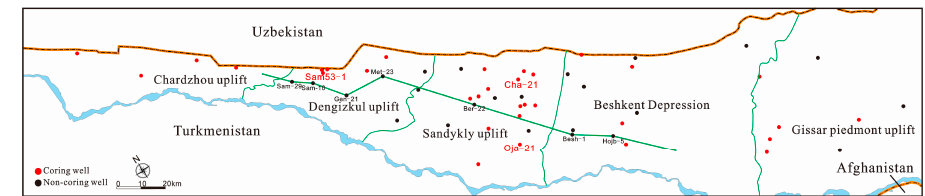
Figure 3. Distribution of wells in Amu Darya right bank area.